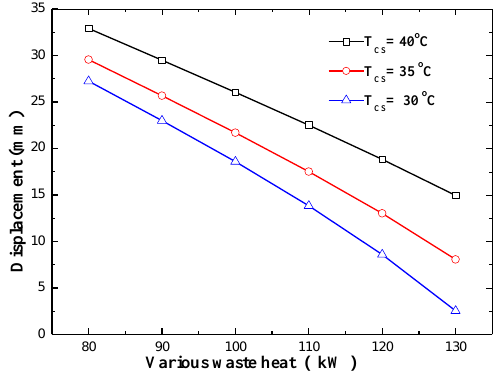
Figure 21. Displacement of volume ratio slide valve vs. various waste heat.